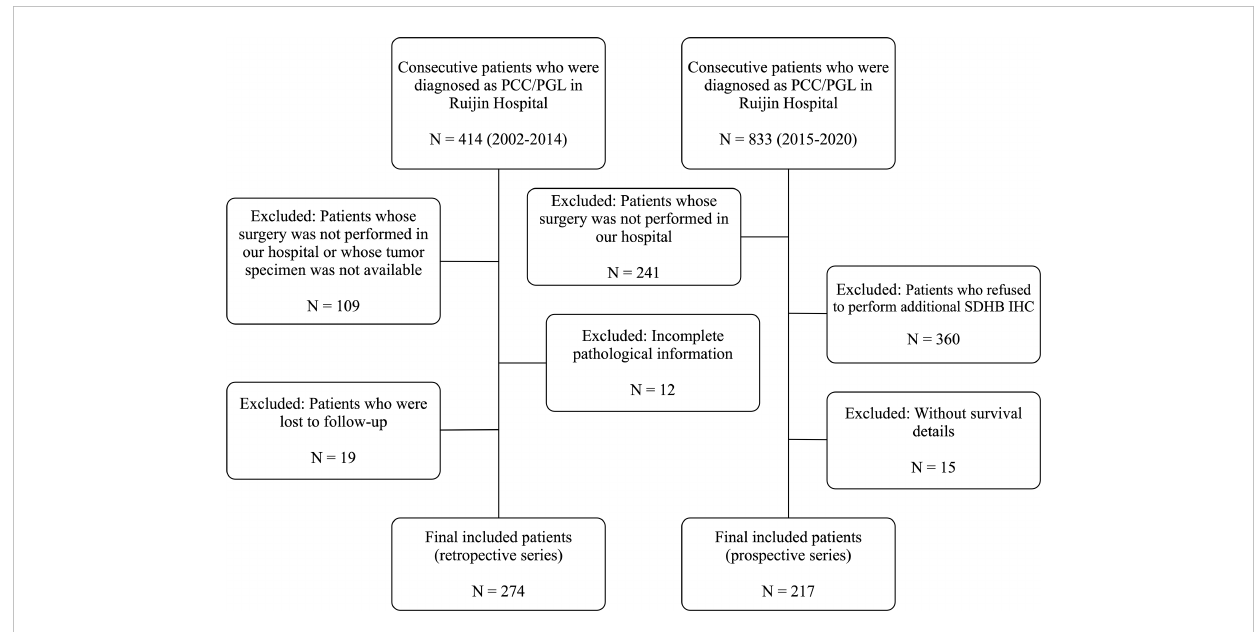
FIGURE 1 Flow diagram of the retrospective series and prospective